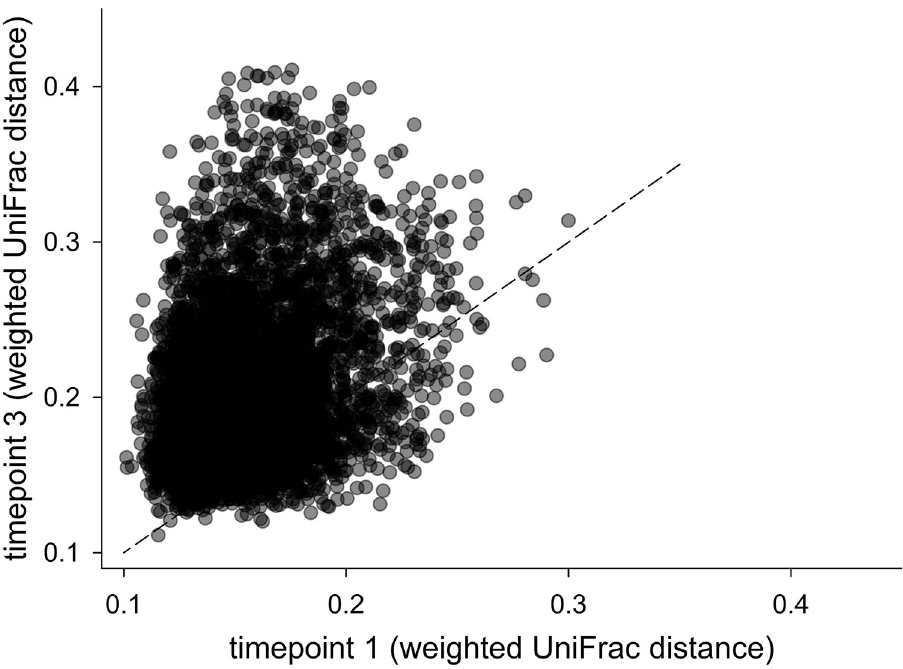
Fig 4. Pairwise UniFrac distances are positively correlated across collections. Each datapoint represents the β diversity between microbiota from two animals measured using weighted UniFrac distance. The plot illustrates the correlation between the β diversity observed in the first and third timepoint; Pearson correlation r = 303, n = 5246, p = 8.1E-112. Dashed line represent y = x.